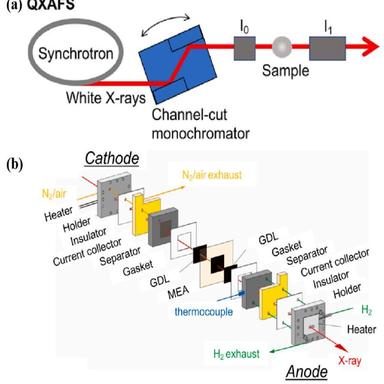
Schematics of (a) Quick-XAFS (QXAFS), (b) an example of laboratory-made PEFC cell for operando XAFS measurements.